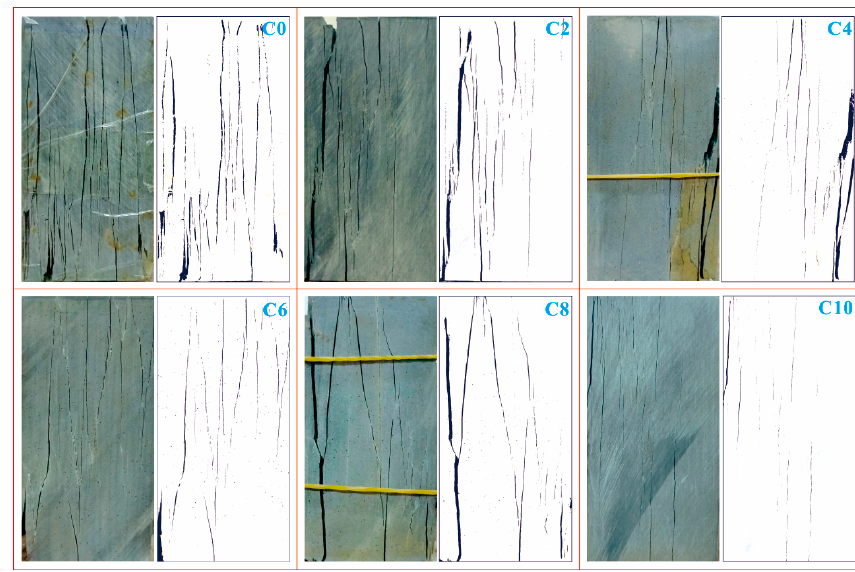
Figure 11. Samples after uniaxial compressive test and related crack sketches.